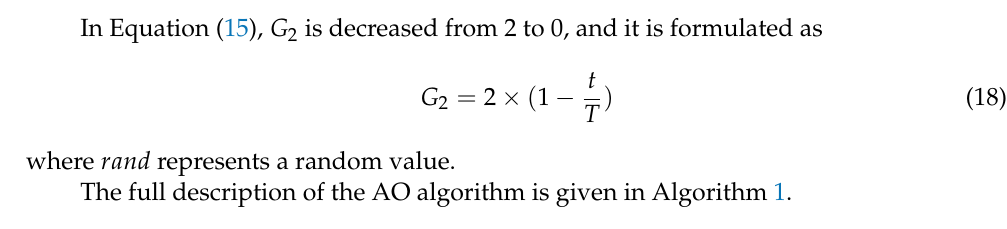
Algorithm 1 Aquila Optimizer